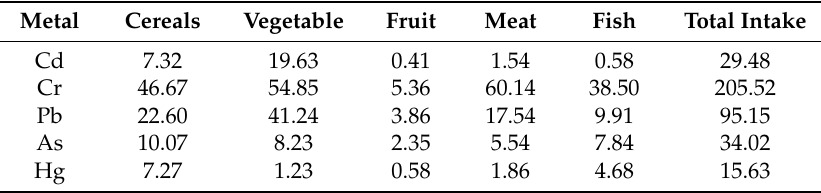
Table 2. Estimated dietary intake of metals via food consumption ( µ g/d).